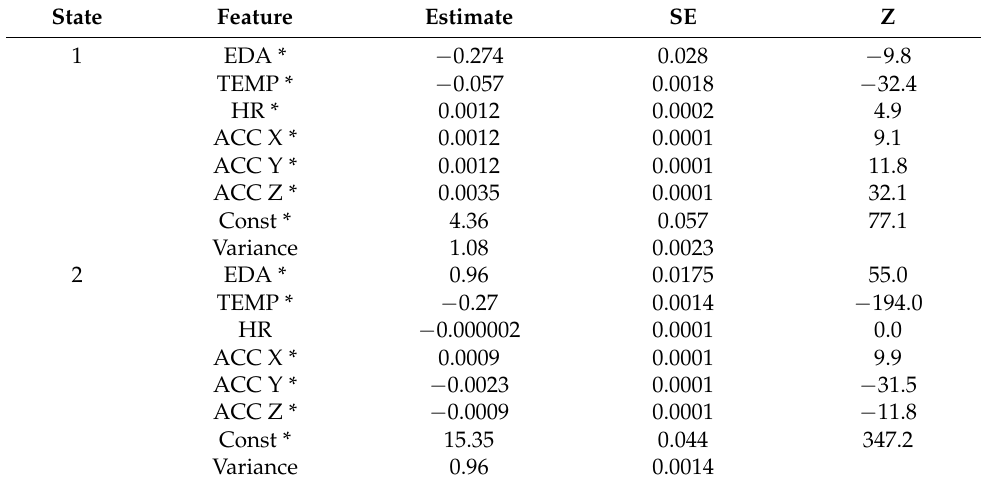
Table 3. Parameter estimates for the two-state Markov-switching dynamic regression